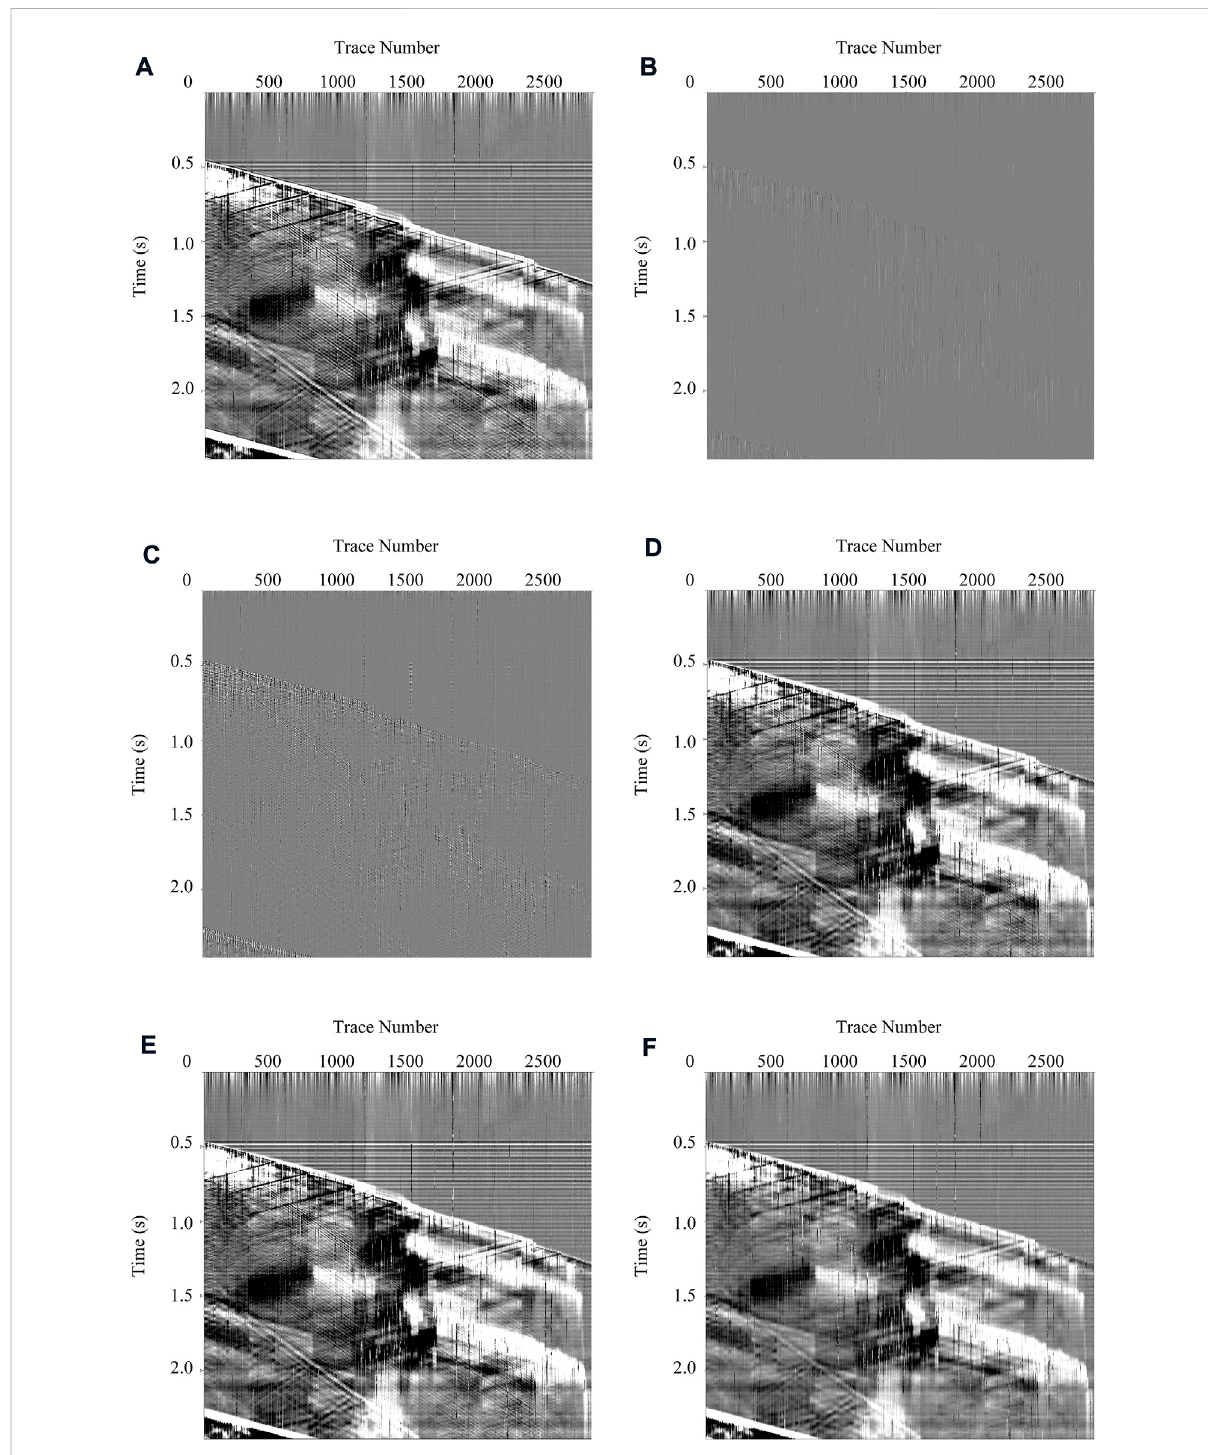
FIGURE 12 Comparisons for the predicted noise of different methods. (A – F) The predicted noise for Band-pass fi ltering, Wavelet transform fi ltering, WNNM, DnCNN, U-Net, and MSI-Net,